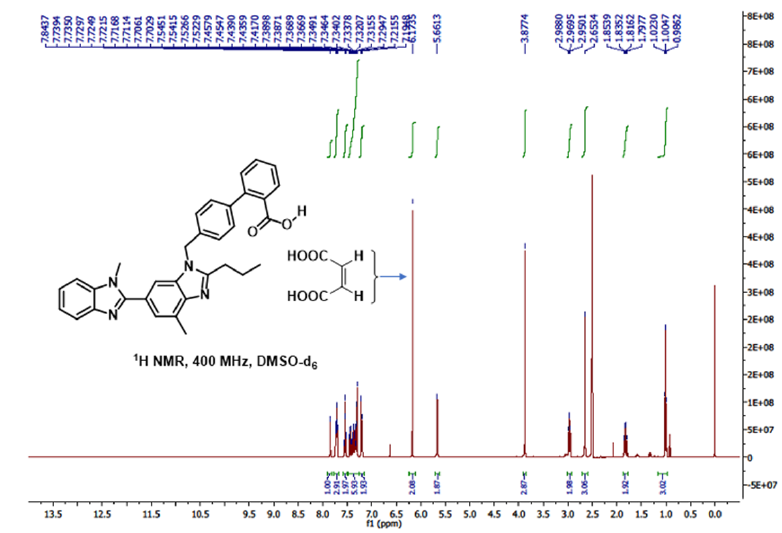
Figure 15. 1 H NMR spectra of TEL-MAL cocrystal .